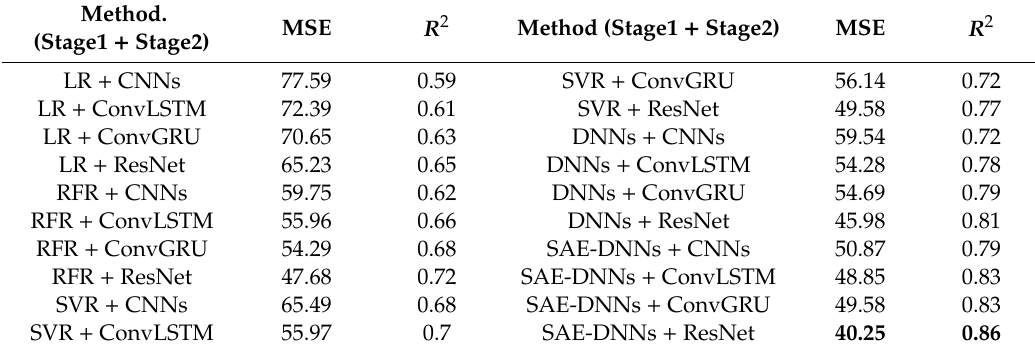
Table 1. Overall performance comparison. SAE–DNN: deep neural network with stacked autoencoders; LR: liner regression; RFR: random forest regression; SVR: support vector regression; DNNs: deep neural networks; CNNs: convolutional neural networks.